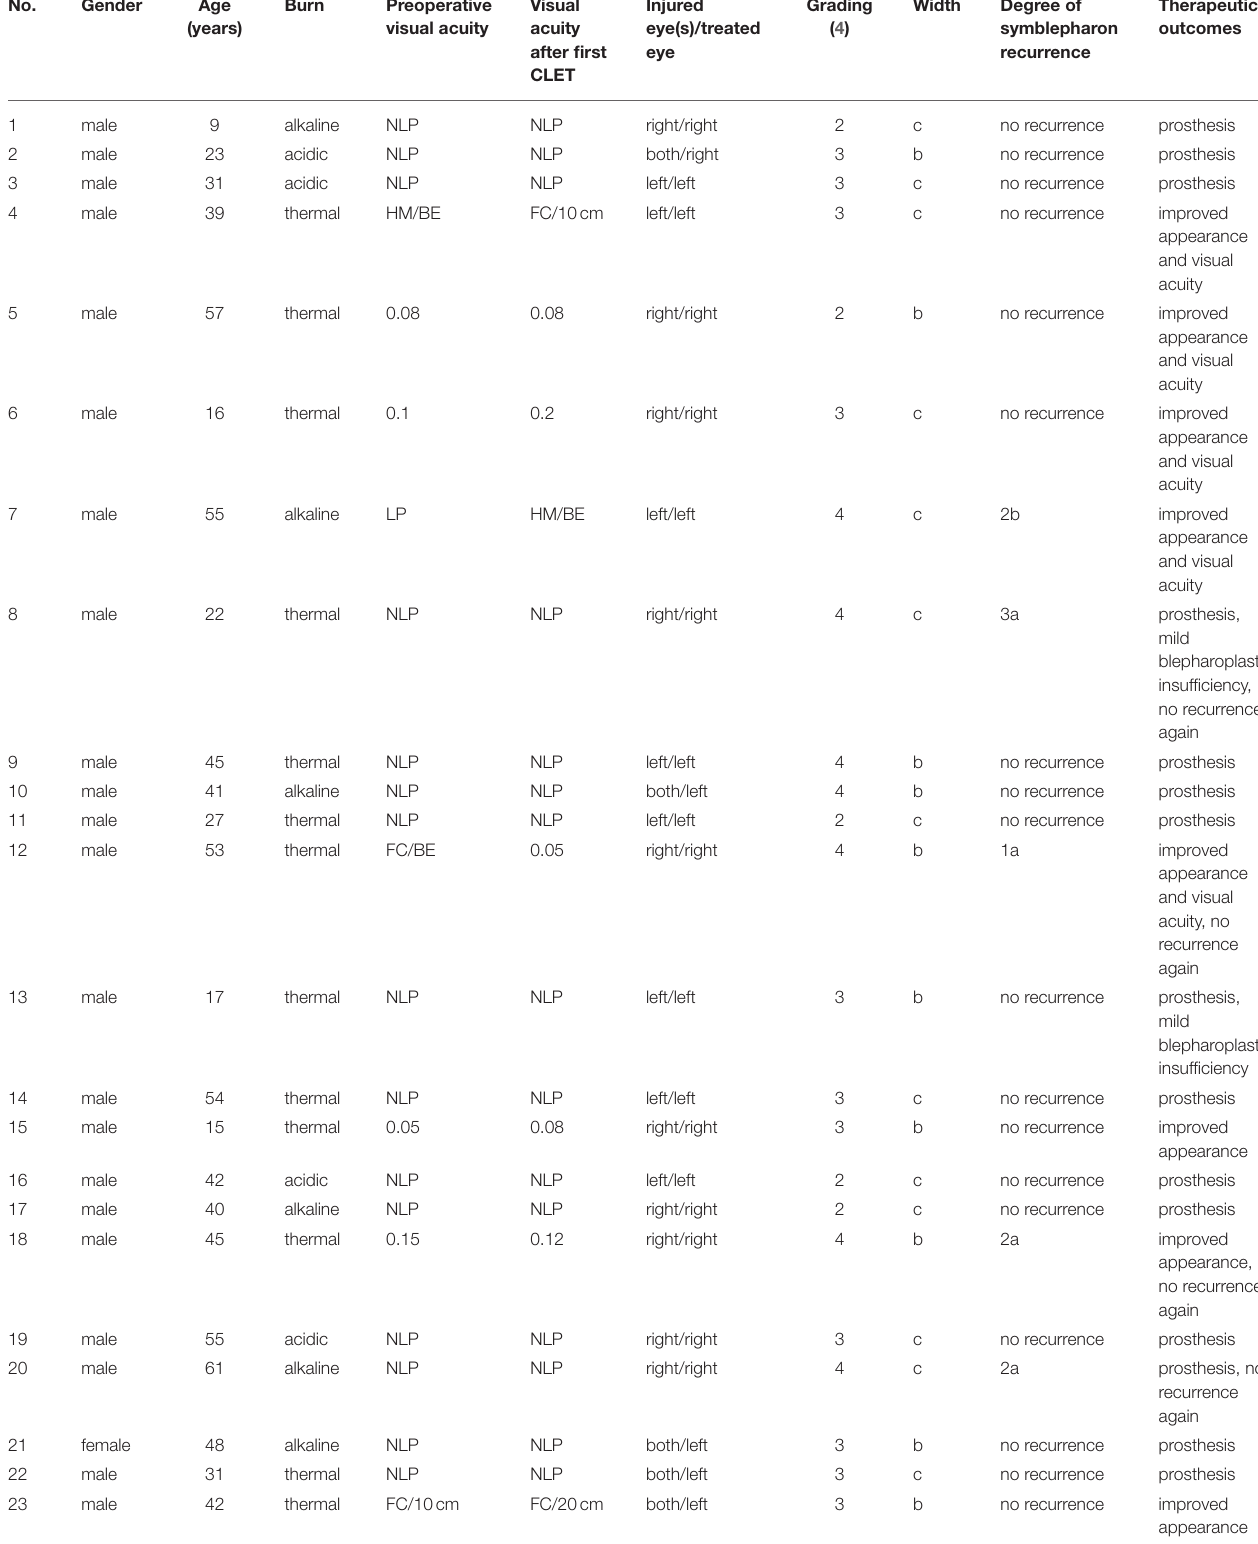
TABLE 1 | Basic information of the involved patients.